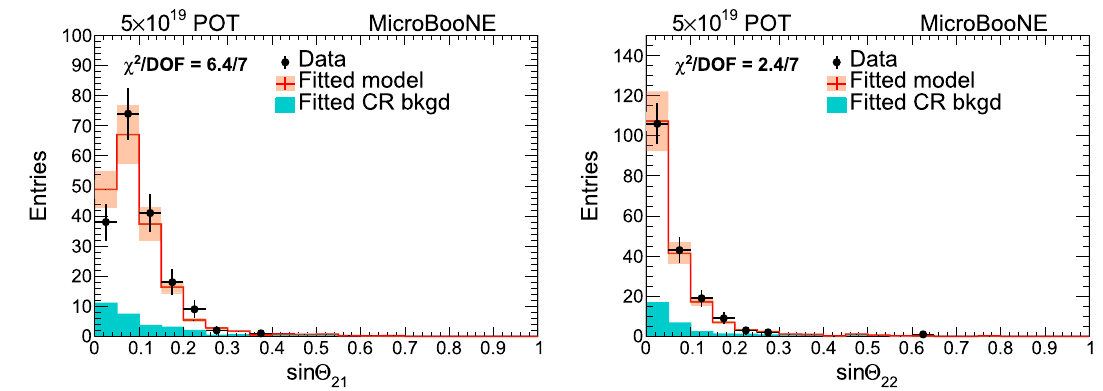
Fig. 20 Multiplicity = 2 sin (cid:17) distribution for candidate muon (left); for second track of the event (right) from neutrino-enriched sample for data and GENIE default MC